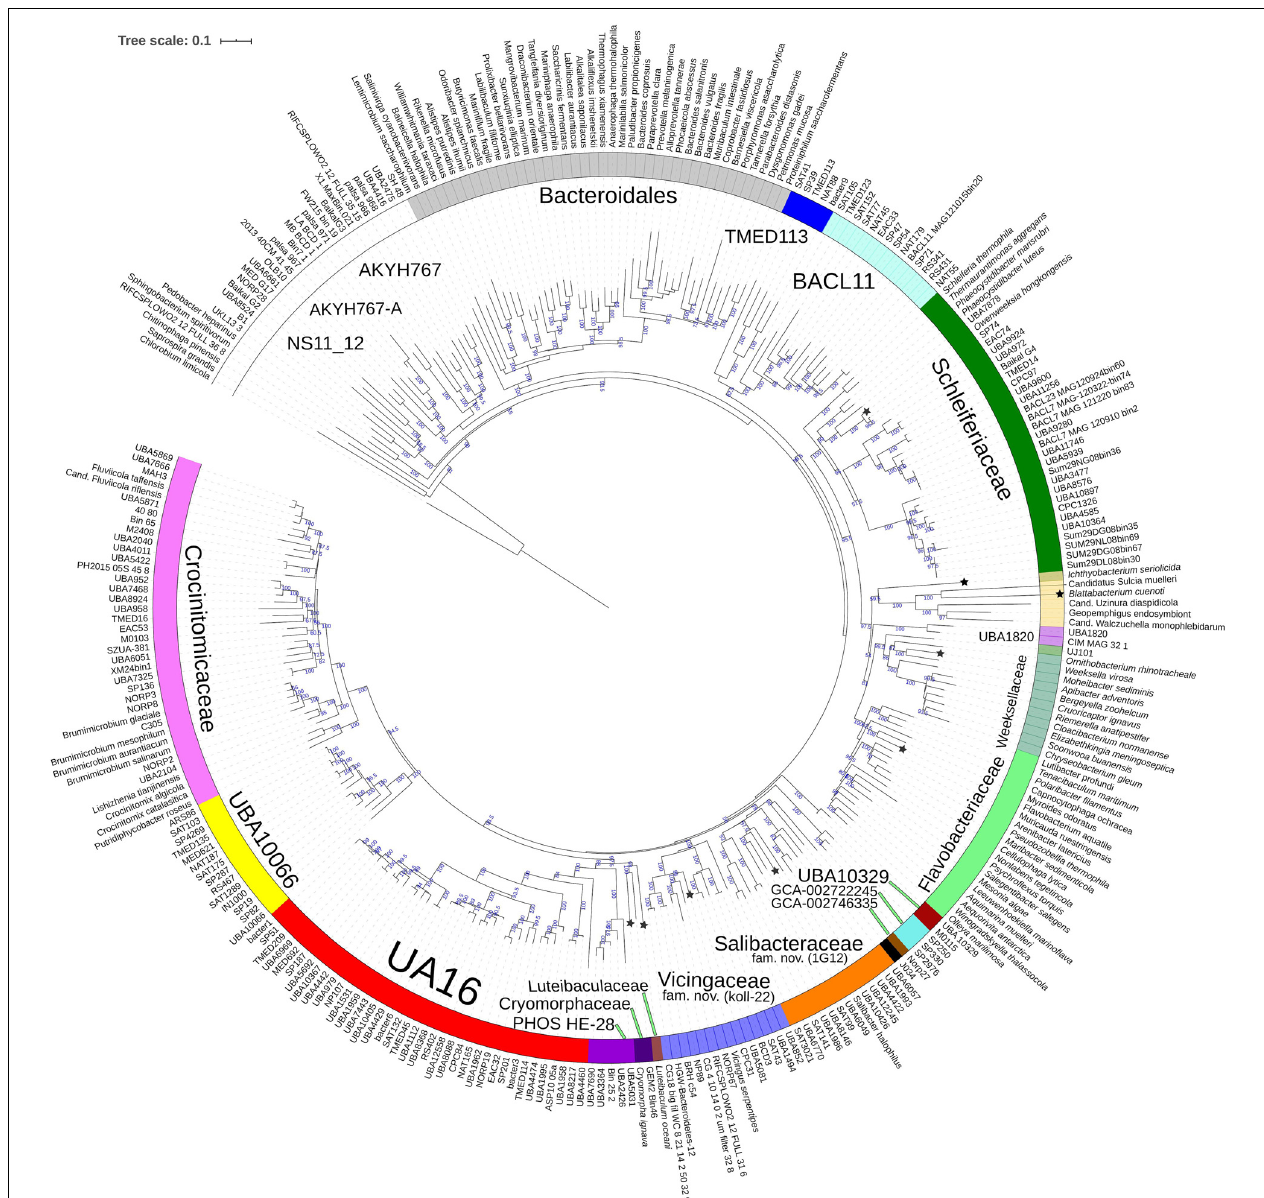
FIGURE 3 | Concatenated protein based BioNJ tree covering family Cryomorphaceae and related taxa of the order Flavobacteriales and including other taxa of the phylum Bacteroidetes . The protein set used is based 33 proteins covering 7530 amino acid positions designated the DnaA/RpsJ-RplQ/Eno set (see “Materials and Methods” for protein list). The tree is a consensus tree generated in IQ-Tree. Bootstrap values converted to a percentile scale are based on 200 replicates. Only bootstraps exceeding 50% are shown. Color strips indicate location of family-level lineages based on the GTDB framework. Family designations include the GTDB and the revised taxonomy determined in this study. Star symbols located on branches indicate validated described type strains relevant to this study. More detailed information on taxa compared is shown in Table 2 and Supplementary Table S1